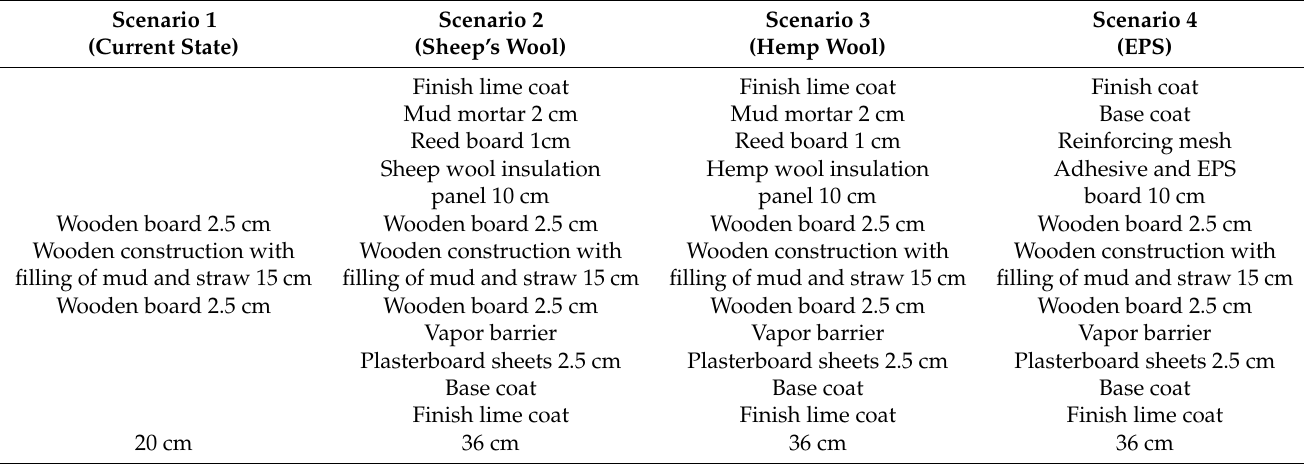
Table 1. Outer wall layers.